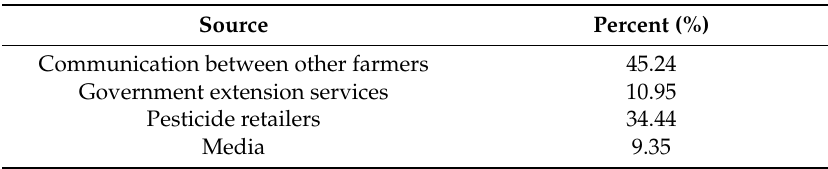
Table 3. Information source of pest control and pesticide use.